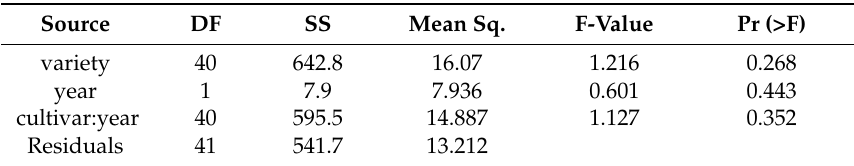
Table 4. Results of an analysis of variance (ANOVA) showing an interaction output for t -resveratrol content by year from the different muscadine grape cultivars (2013–2015). Source DF SS Mean